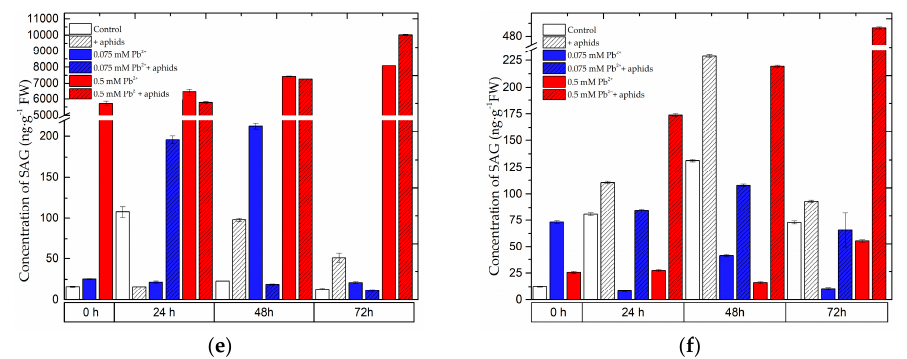
Figure 1. The effect of lead and A. pisum on accumulation of total salicylic acid (TSA) ( a , b ), salicylic acid (SA) ( c , d ) and salicylic acid glucoside (SAG) ( e , f ) in roots ( a , c , e ) and leaves ( b , d , f ) of pea seedlings. The data were obtained in three independent experiments and statistically analysed using ANOVA ( p -values at α = 0.05). Hypotheses on the equality of means were verified by the two-sample t -test. To account for multiple testing, we used the Bonferroni correction (statistically significant differences are shown in Table S1).